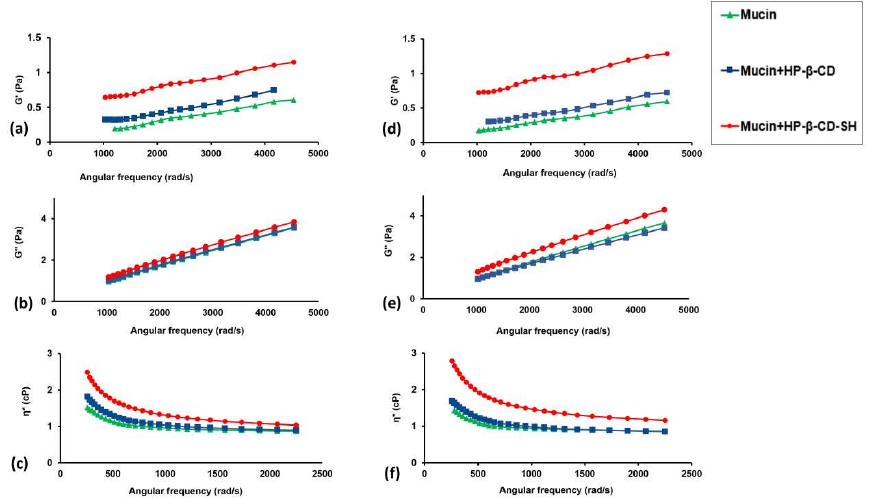
Figure 2. ( a ) Elastic modulus (G’), ( b ) viscous modulus (G’’), ( c ) complex viscosity ( η *) of HP- β -CD and HP- β -CD-SH with respect to the mucin dispersion at time 0. ( d ) Elastic modulus (G’), ( e ) viscous modulus (G’’), ( f ) complex viscosity ( η *) of HP- β -CD and HP- β -CD-SH with respect to the dispersion of mucin after 1 h.